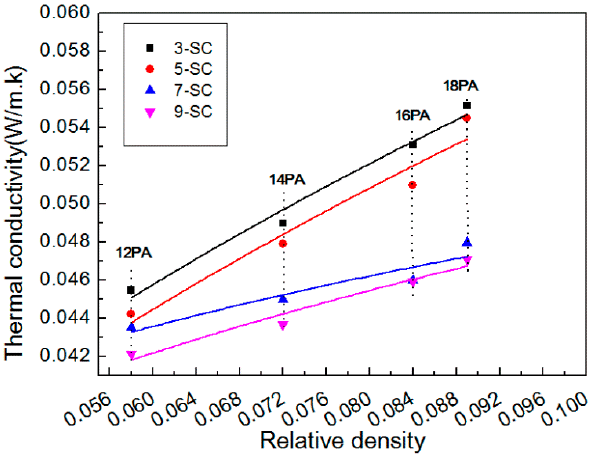
Figure 6. Thermal conductivity vs relative densities of PA foams.